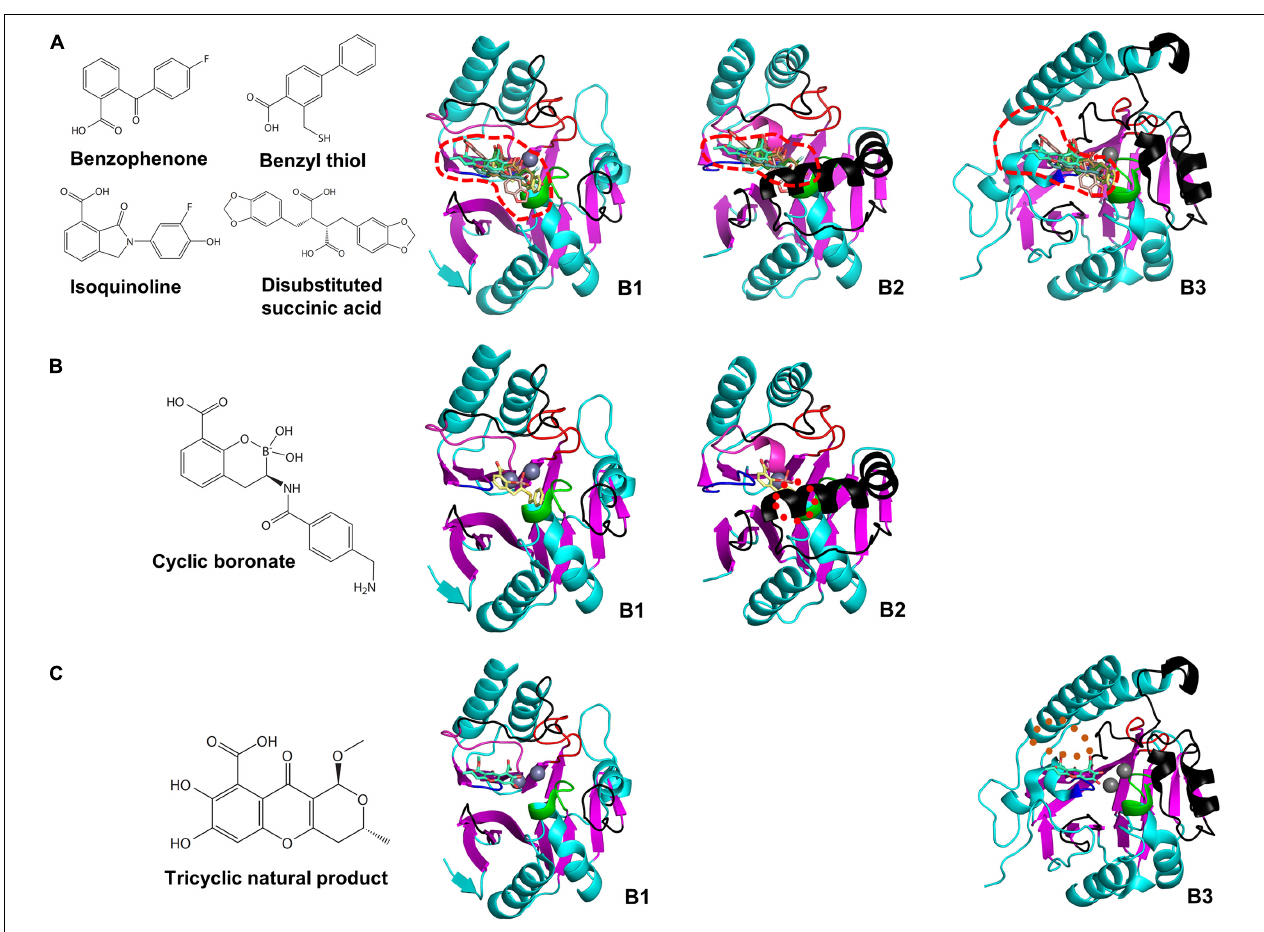
FIGURE 6 | The chemical structures of B1 MBL inhibitors and their superimposed structures on the representative B1, B2, and B3 MBLs. The chemical structures of (A) benzophenone, benzyl thiol, isoquinoline, disubstituted succinic acid, (B) cyclic boronate, and (C) tricyclic natural product, and their superimposed structures on the B1, B2, and B3 MBLs of NDM-1, CphA, and AIM-1, respectively. The substrate-binding pockets of the B1, B2, and B3 MBLs are represented by red dashed lines. The red dotted circle represents the clashed region between the superimposed cyclic boronate and the substrate-binding pocket of B2 MBL. The brown dotted oval represents the space between the tricyclic natural product and substrate-binding pocket of B3 MBL.